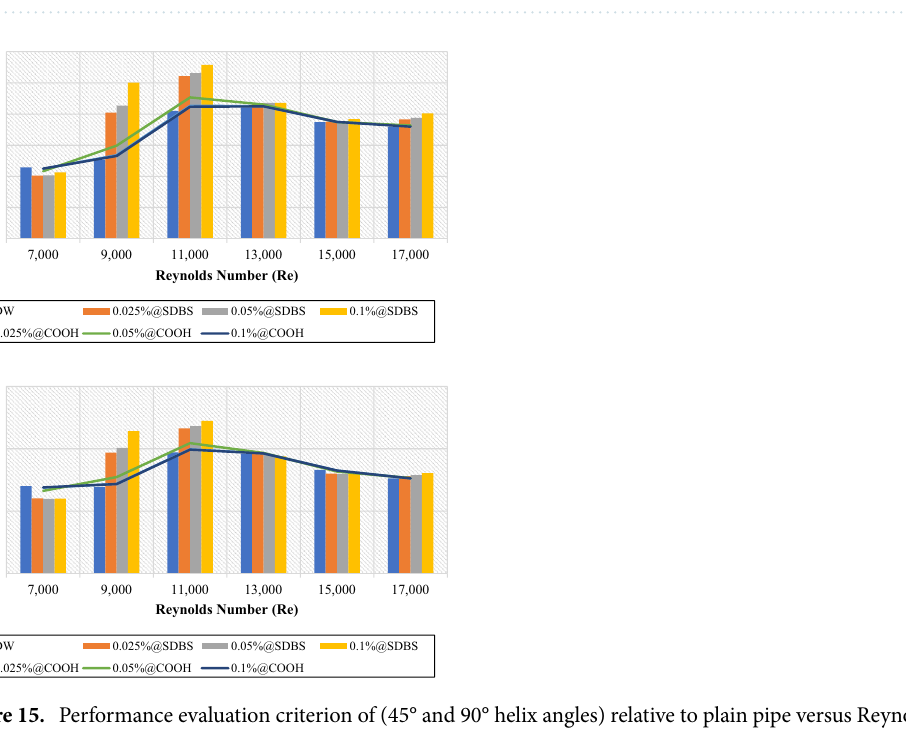
Figure 14. Pressure loss of (45° and 90° helix angles) relative to plain pipe versus Reynolds numbers for different nanofluids.